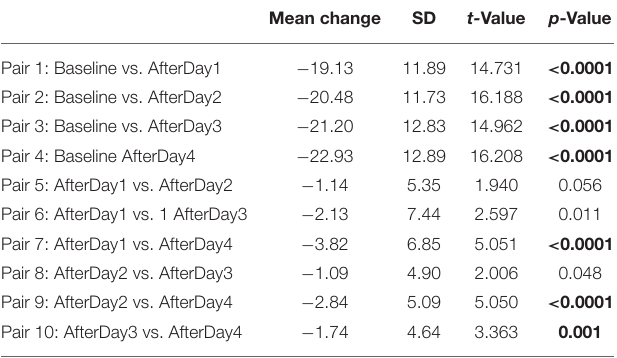
Figure 1 for study recruitment flow diagram).